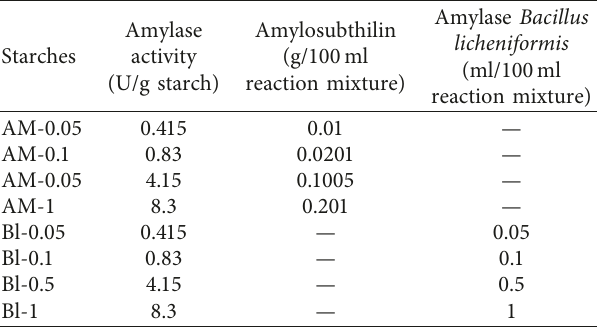
Table 1: Code of fermented modified starches.